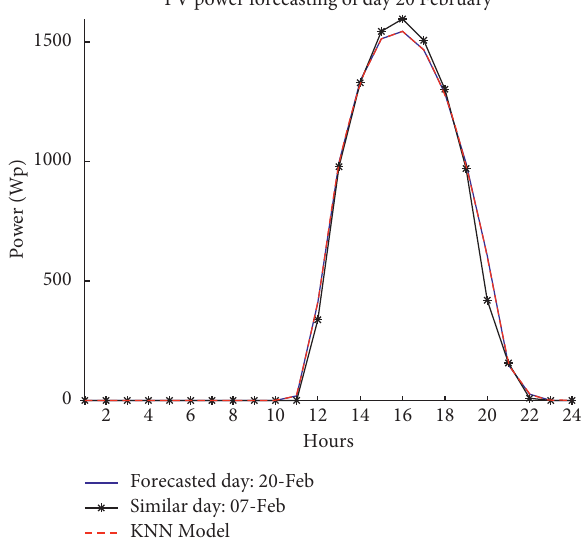
Figure 15: Similarity algorithm combined with KNN for forecasting the PV power of 20 February.